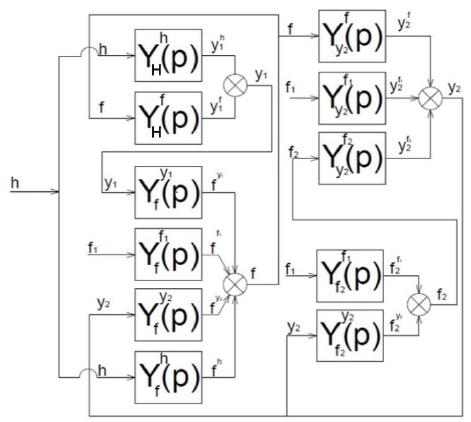
Figure 5. The block diagram of the connection of the transfer functions of the links of the heat exchanger.